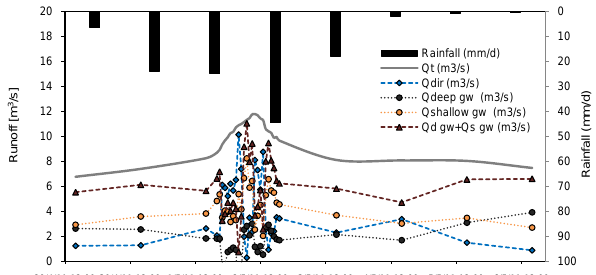
Figure 9 Results of the three-component separation using dissolved silica and oxygen-18 as tracers for Fig. 9. Results of the three-component separation using dissolved event M3 (see Fig. 2b) investigated from 29 April 2011 to 6 May 2011 at Migina station. Q dgw + Q sgw is the silica and oxygen-18 as tracers for event M3 (see Fig. 2b) in- sum of deep and shallow groundwater components. vestigated from 29 April 2011 to 6 May 2011 at Migina sta- tion. Q dgw + Q sgw is the sum of deep and shallow groundwater